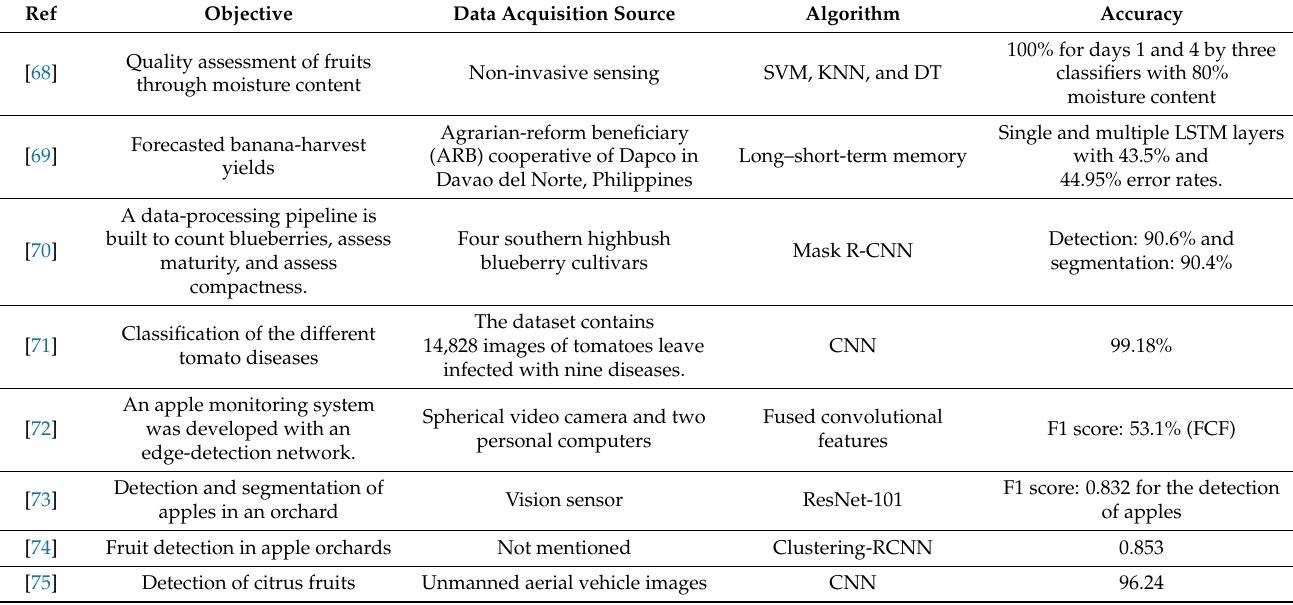
Table 3. AI implementation for horticulture with accuracy and data-acquisition